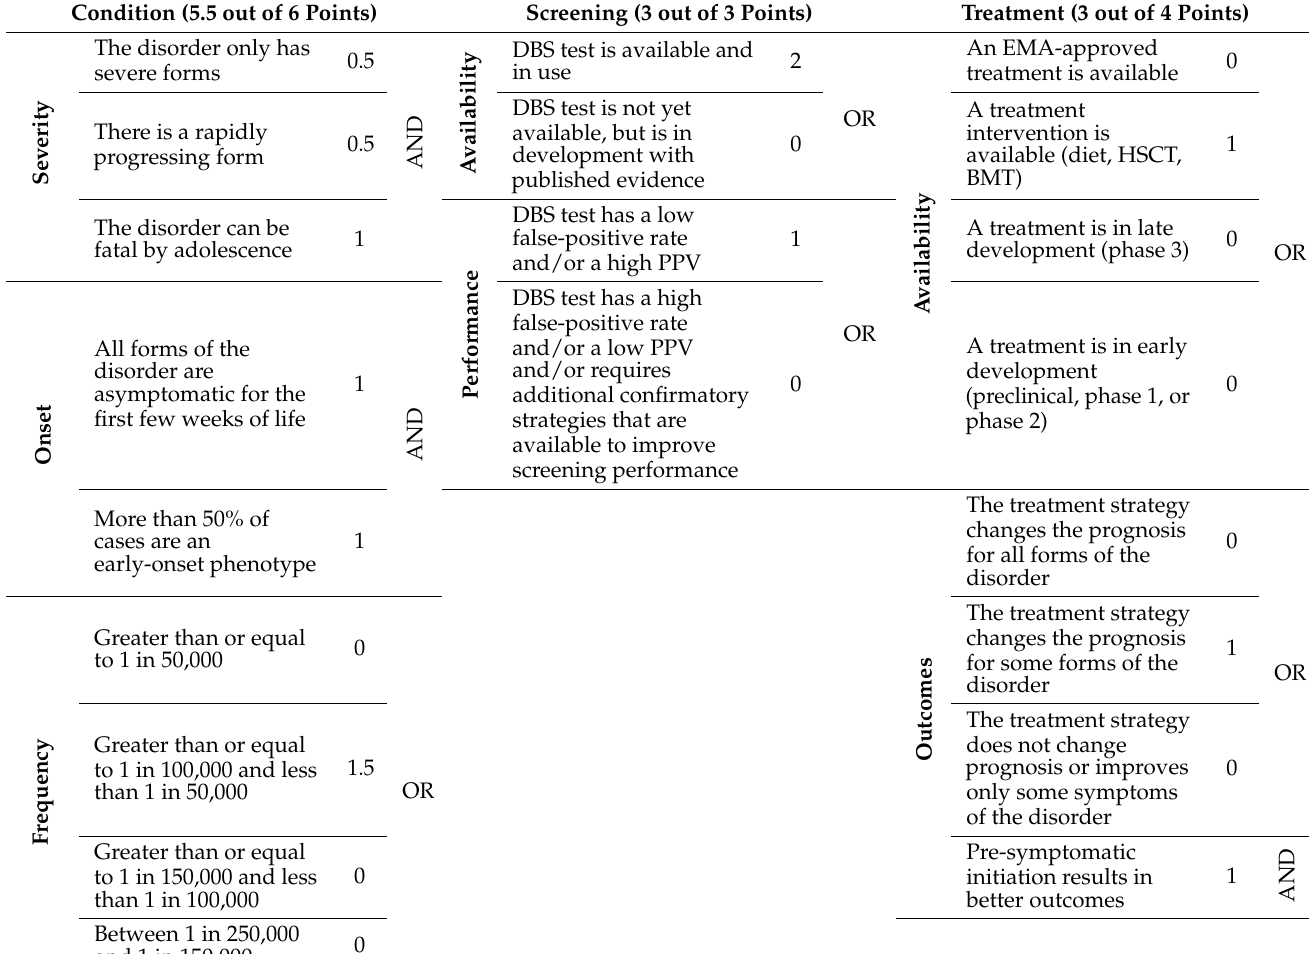
Table A1. Glutaric aciduria type 1 (GA1), 11.5